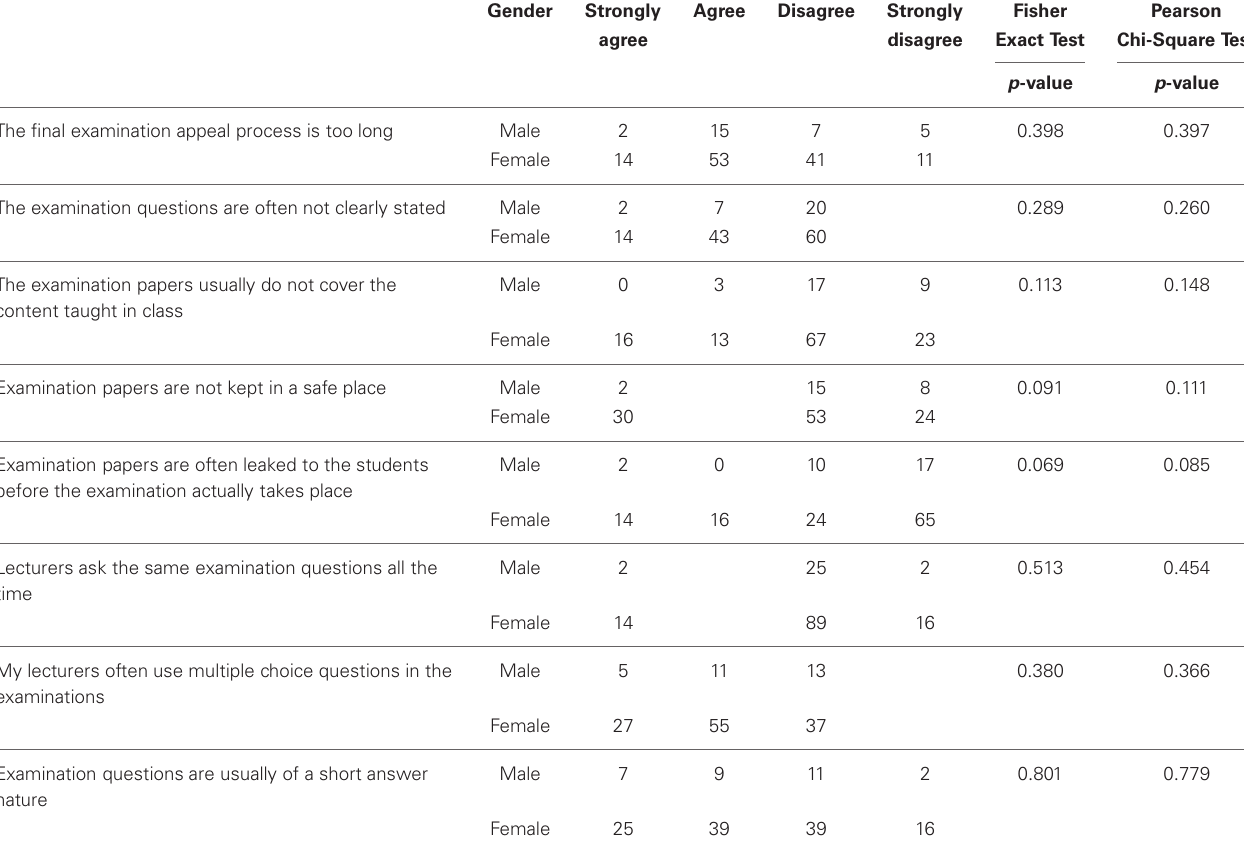
Table 6 | Factors associated with the students’ views and perceptions on final examinations.